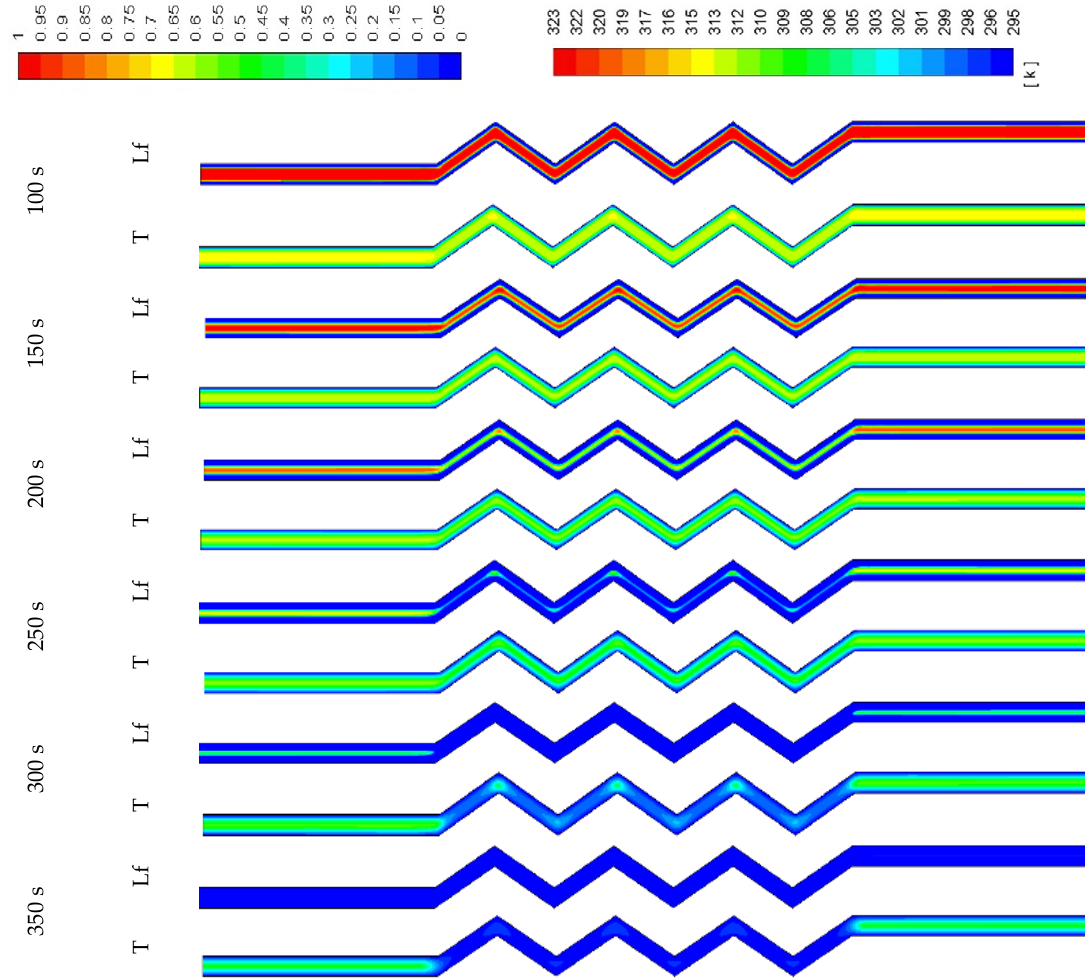
Figure 10. Contours of the liquid-fraction and temperature during the solidification process in the horizontal corrugated channel for the standard width (0.9 cm).